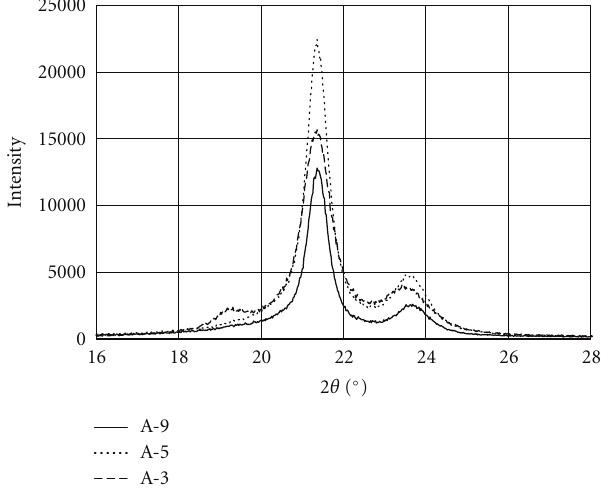
Figure 5: Measured X-ray spectra of some LLDPE monofilaments.